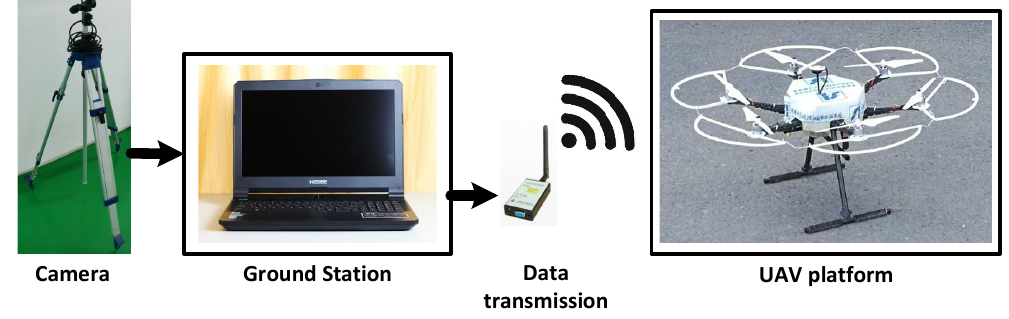
Figure 19. The test UAV was a self-assembly six-rotor UAV with a wheelbase of 55 cm, height of 40 cm, and weight of 1.2 kg. The camera in this system was a Basler industrial camera with a resolution of 640 × 480 pixels.